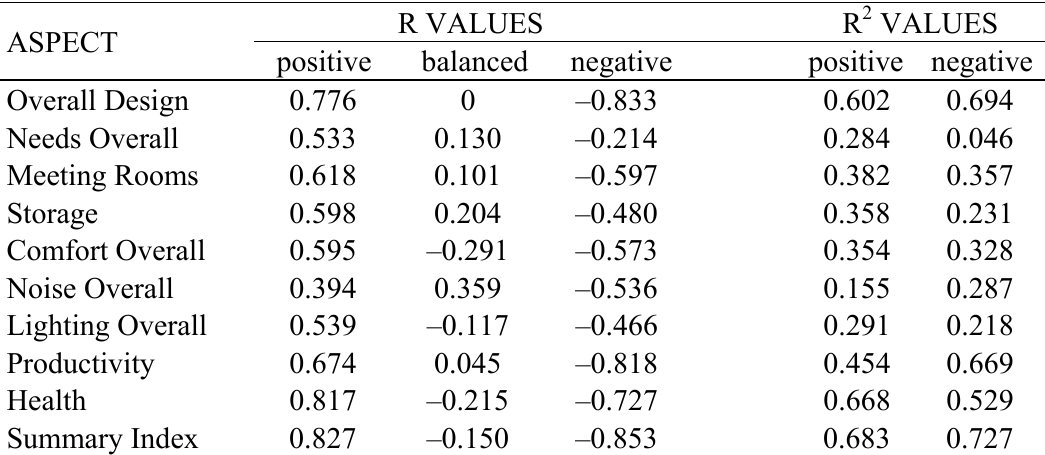
Table 2. Correlation Coefficients (R values) and Coefficients of Determination (R 2 values) between average scores and percentages of total comments for nine aspects of the buildings, and the Summary